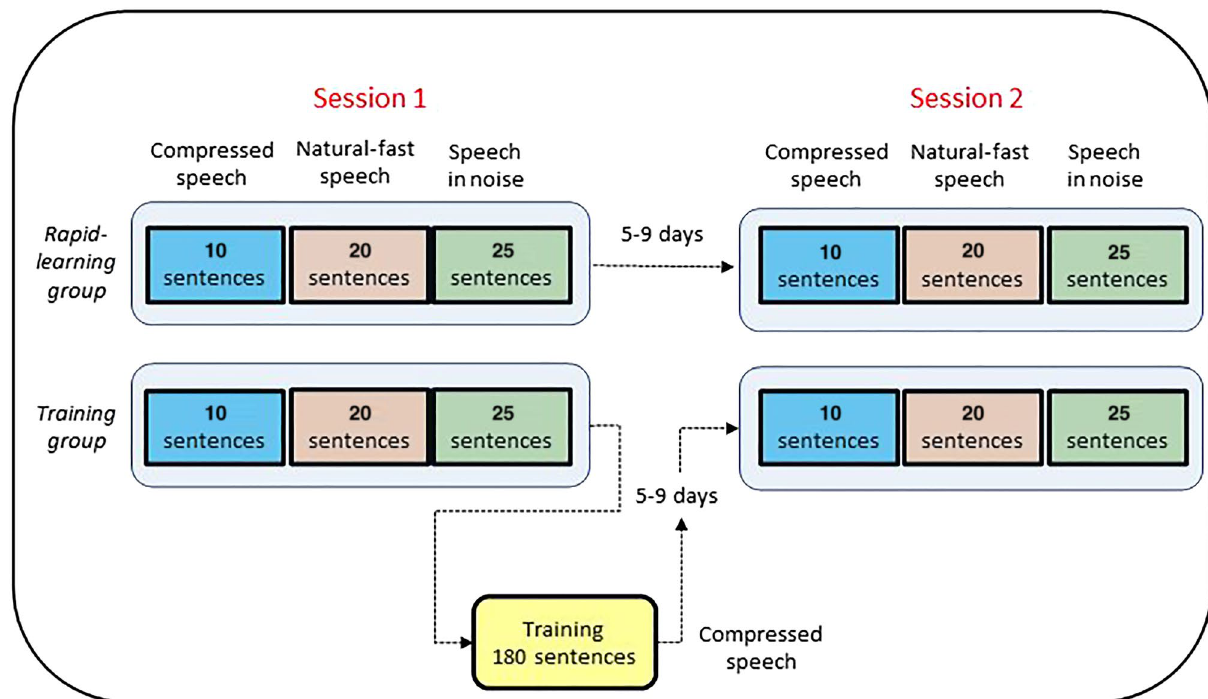
Figure 1. Overview of the design of Experiment 1. Each group completed two test sessions (Session 1, Session 2; the order of the three speech tests in each session was counterbalanced); The training group received additional